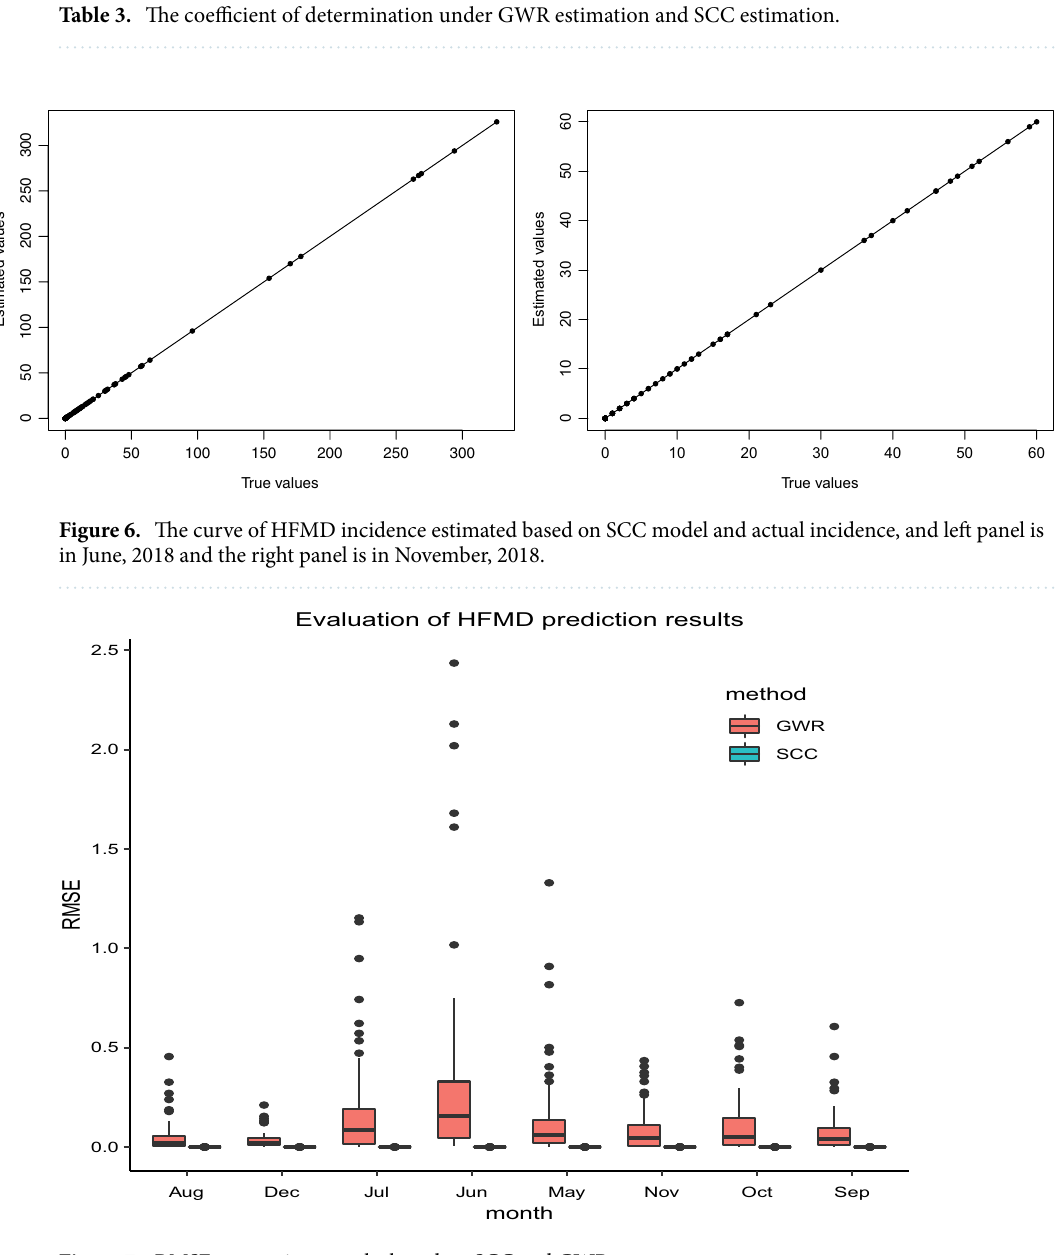
Figure 7. RMSE comparison results based on SCC and